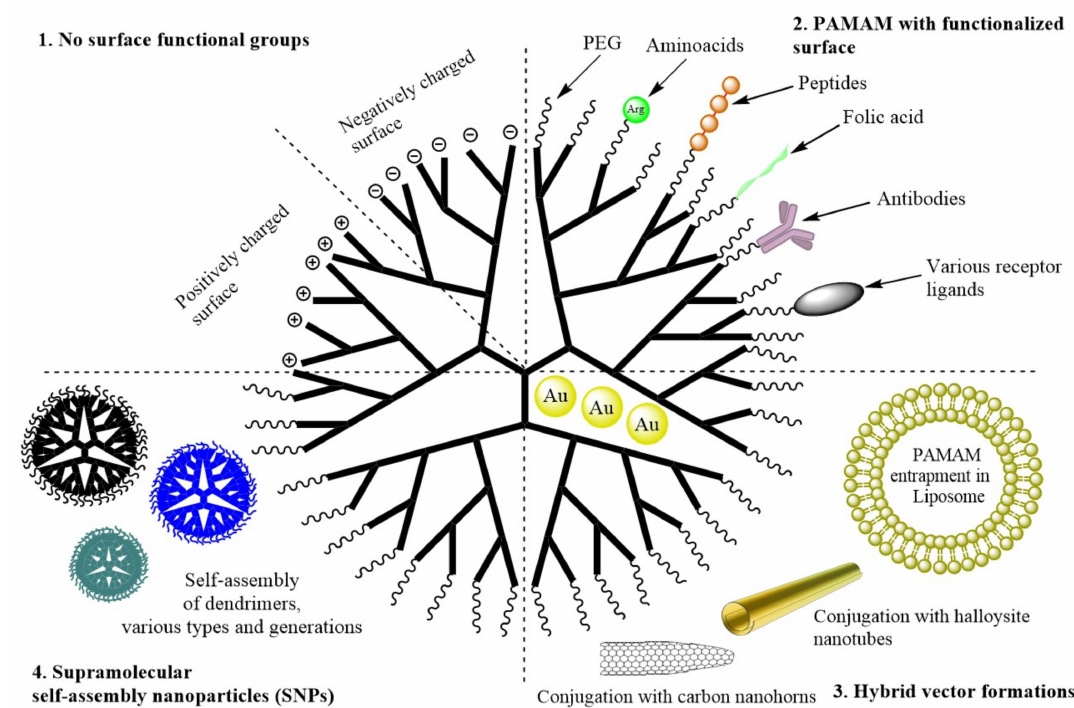
Figure 2. Schematic representation of the PAMAM dendrimer modification strategies covered in the